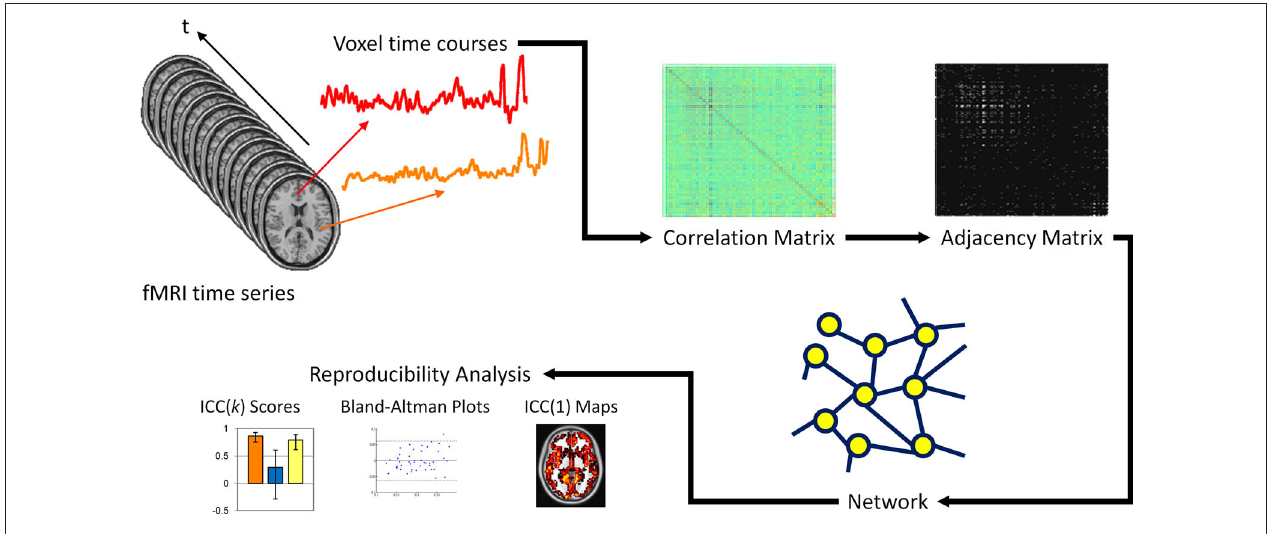
matrix. From the adjacency matrix, graph metrics are calculated at every node in the network and averaged to produce mean network metrics. From these graph metrics, ICC( k ) scores, Bland–Altman plots and ICC(1) maps are